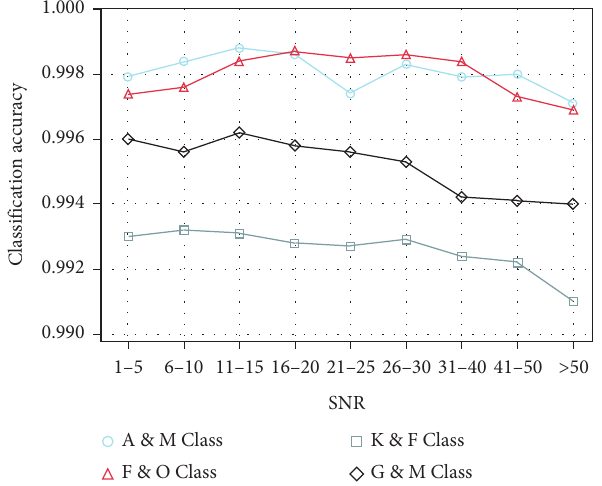
Figure 8: The accuracy of binary classification of each group of stars under different SNR stellar